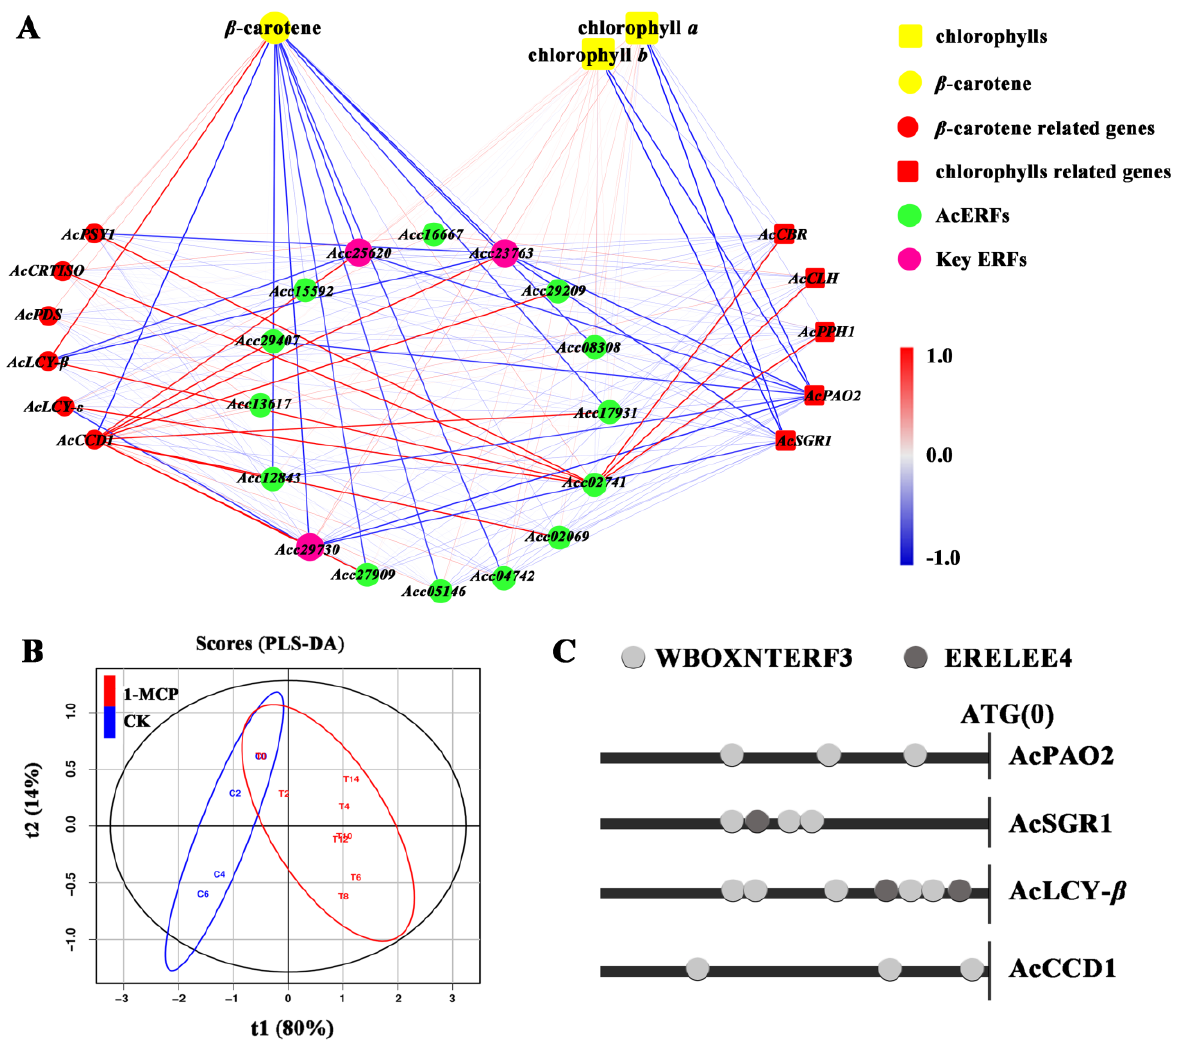
Figure 6. Correlation network and promoter analyses. ( A ) Correlation network analysis for pigment contents, pathway related genes, and the tested ERFs. Correlations are indicated by the colored bar. ( B ) The PLS-DA analysis for genes with significant correlations. ( C ) The promoter analysis of four important pathway related genes.